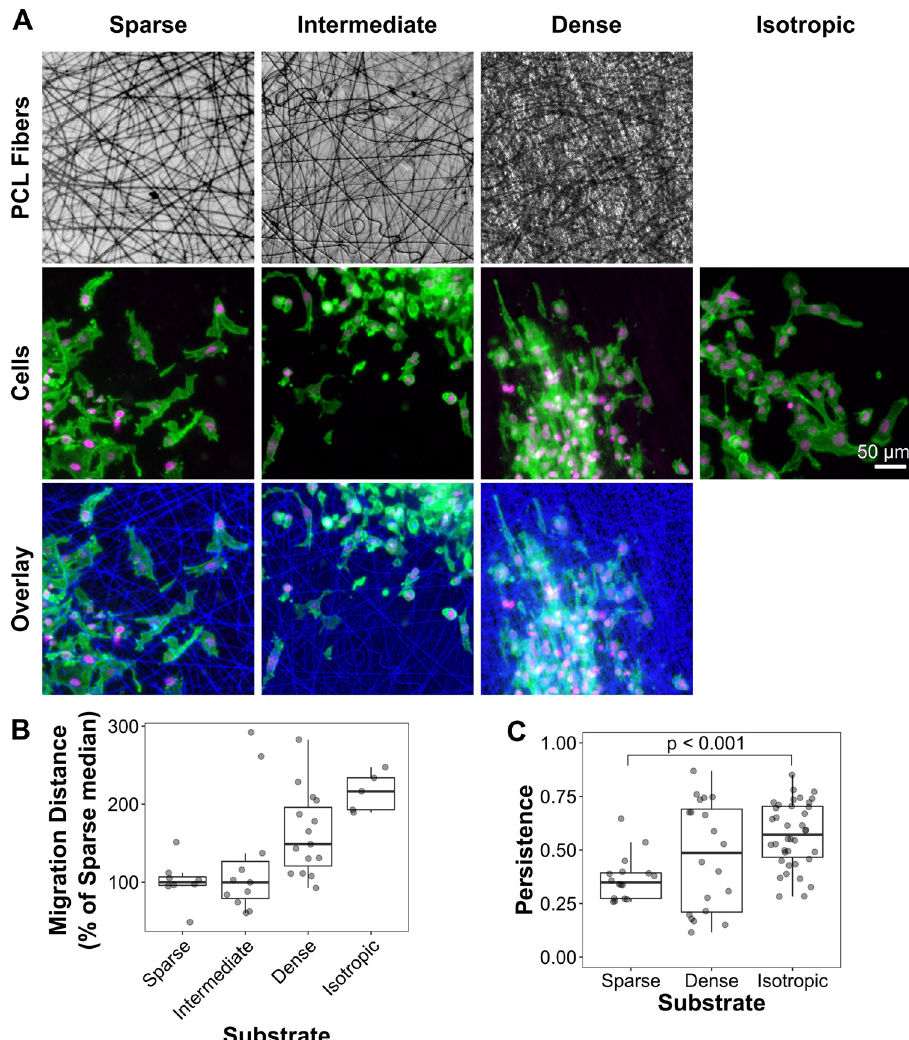
Fig 5. Fiber density affects migration persistence. Spheroids were seeded on top of PCL substrates of all three fiber densities as well as on plastic well-plates (B) or glass coverslips (A, C) (both labeled “isotropic”). ( A ) Representative images of cells migrating out of spheroids onto PCL scaffolds or glass (“isotropic”) imaged 12 h post-seeding. Brightfield images of the PCL fibers are shown in blue in the overlay. Nuclei (DAPI) are labeled magenta; cell bodies (phalloidin-stained actin) are labeled green. Scalebar = 50 μ m. ( B ) After culturing for 24 h, the cells were imaged and their distance from the original spheroid boundary was calculated. Each point represents the median cell migration distance for a single spheroid, expressed as a percentage of the overall median of all spheroids from the Sparse samples. Box-and-whisker plot: dark line indicates median; box encompasses 25th-75th percentiles; whiskers extend to the largest value no larger than 1.5 times the box width (interquartile range). Each dot represents data from an individual cell. All groups are significantly different from the others (p < 0.05) except for Intermediate-Isotropic (p = 0.06) and Intermediate-Sparse. Wilcox Rank-Sum Test; p-values adjusted using the Benjamini-Hochberg (false discovery rate) method; from left to right, n = 8, 11, 15, 5. Data were collected from three independent experiments. ( C ) In separate experiments, spheroids were seeded on Sparse, Dense, and glass (Isotropic) substrates and imaged over time as in Fig 4. (Note that the Isotropic data are the same data as the glass sample in Fig 4B.) Each point represents the persistence of a single cell. The persistence of cells on Sparse and Isotropic substrates are significantly different (p < 0.001). The average persistence of cells on Dense substrates is intermediate between the other two, but not significantly different from either (p = 0.12). Welch’s two-tailed t-Test; p-values adjusted using the Benjamini-Hochberg (false discovery rate) method; from left to right, n = 16, 20, 38. Data were from four independent